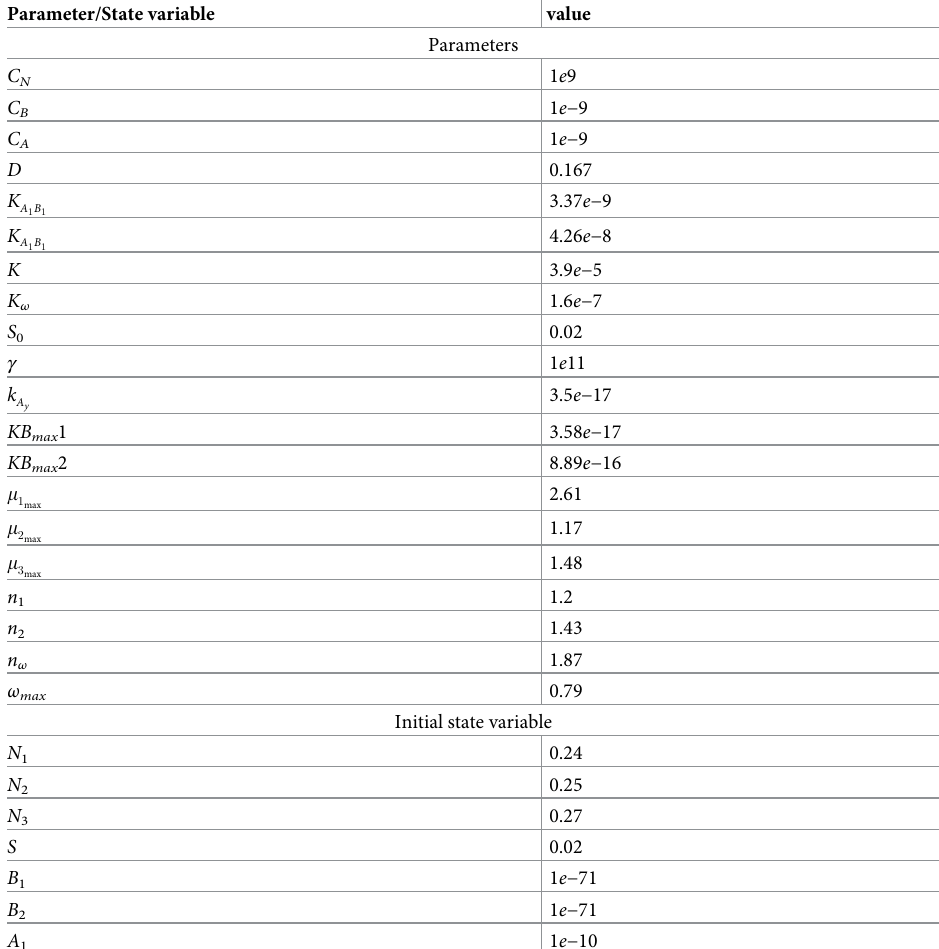
Table 2. Fixed parameters used in Figs 4D and